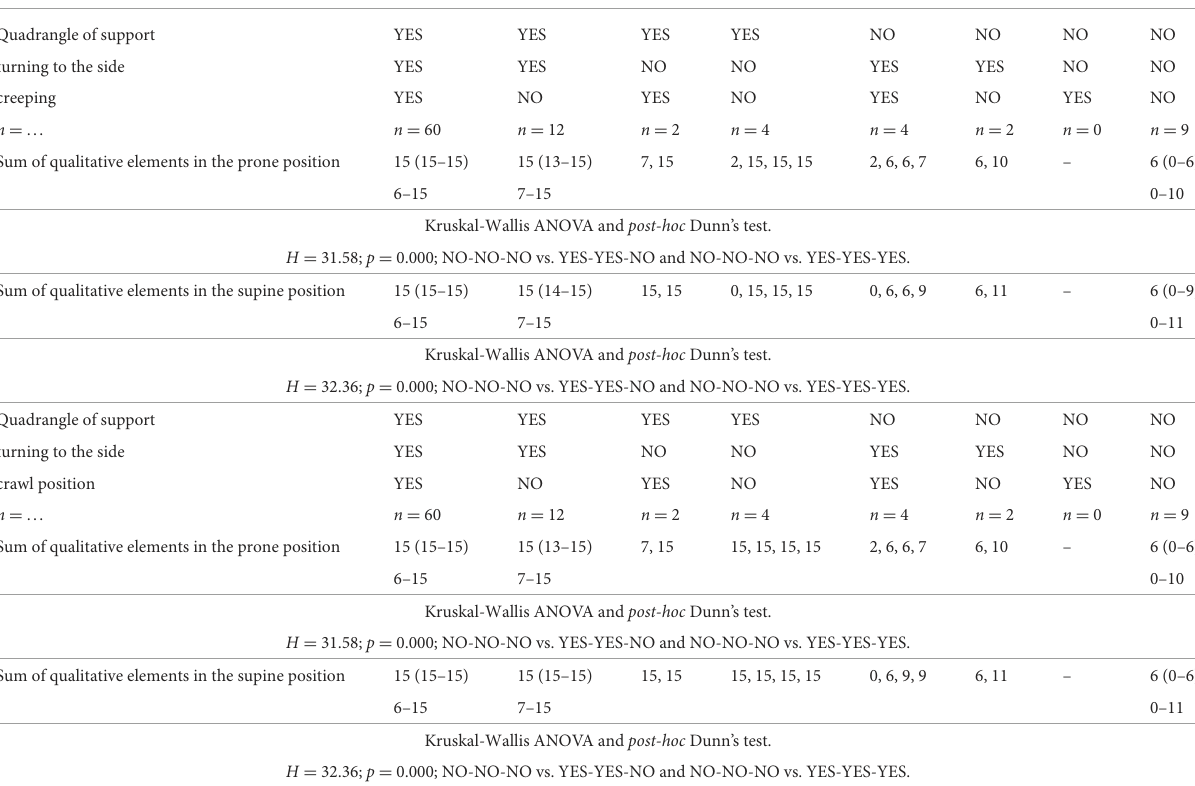
TABLE 1 The motor development in supine position: quadrangle of support—turning to the side—creeping OR crawl position, according to the quality of motor performance assessed at the age of 3 months, in prone and supine positions.